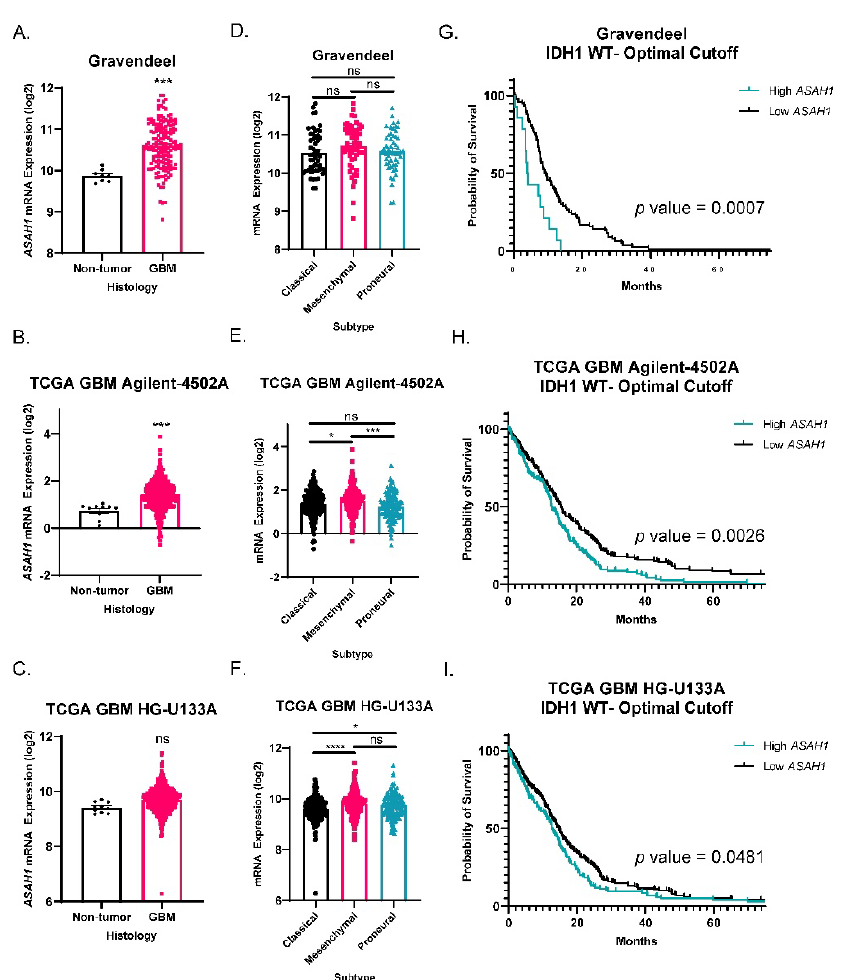
Figure 1. ASAH1 correlated with worse survival in IDH1 wildtype GBM patients. Datasets were accessed using GlioVis (http://gliovis.bioinfo.cnio.es) (accessed on 25 February 2021). ASAH1 mRNA expression in GBM compared to non-tumor samples in ( A ) Gravandeel ( n = 8 for non-tumor, n = 159 for GBM), ( B ) TCGA GBM Agilent-4502A platform ( n = 10 for non-tumor, n = 489 for GBM), and ( C ) TCGA GBM HG-U133A platform ( n = 10 for non-tumor, n = 528 for GBM). Data were analyzed by independent t -test. ASAH1 mRNA expression in the three subtypes of GBM ( D ) Gravandeel ( n = 52 for classical, n = 54 for mesenchymal, n = 53 for proneural), ( E ) TCGA GBM Agilent-4502A platform ( n = 182 for classical, n = 156 for mesenchymal, n = 121 for proneural), and ( F ) TCGA GBM HG-U133A platform ( n = 199 for classical, n = 166 for mesenchymal, n = 163 for proneural). Data were analyzed by one-way ANOVA followed by Dunnett’s multiple comparisons test and displayed as means ± SEM. Kaplan–Meier survival curves for IDH1 wildtype GBM patients using optimal cutoff to determine high and low ASAH1 expression. ( G ) Gravandeel ( n = 93), ( H ) TCGA GBM Agilent-4502A platform ( n = 339), and ( I ) TCGA GBM HG-U133A platform ( n = 372). Groups were compared by log-rank test. Not significant (ns), * p < 0.05, *** p < 0.001, **** p <